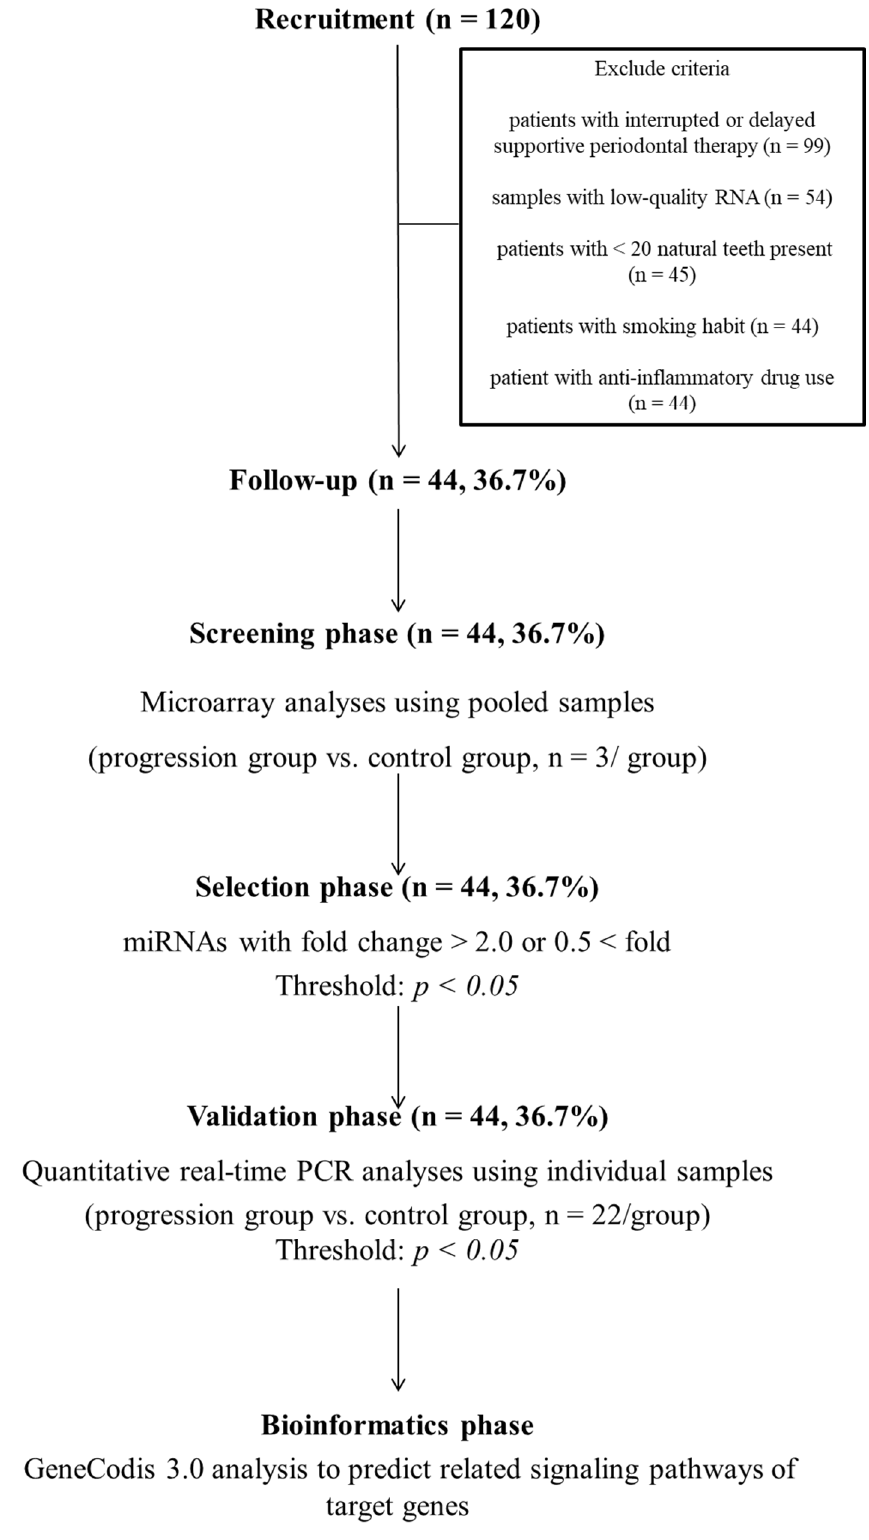
Figure 1. An overview of the experimental